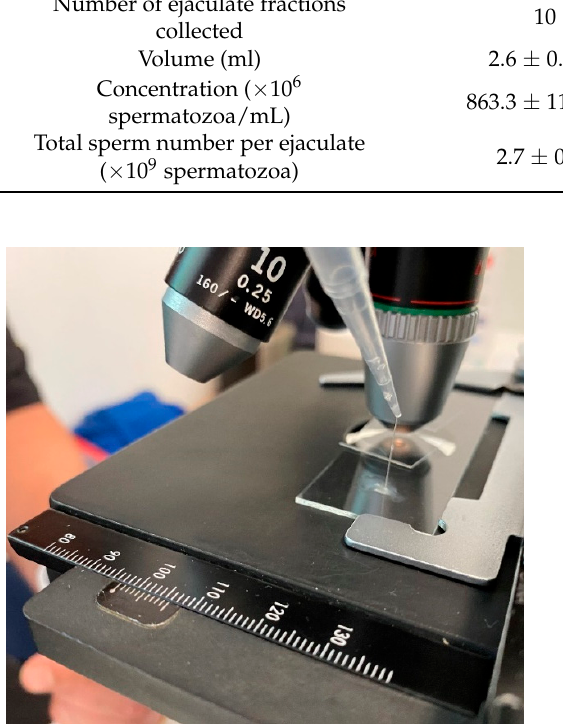
Table 1. Semen characteristics of the sperm-rich and viscous, low sperm fractions collected in Experiment 1 and 2, from southern white rhinoceros bulls (n = 9) via electroejaculation. Data is mean ± SEM. Columns which differ in superscript indicate significant differences between means ( p < 0.05).